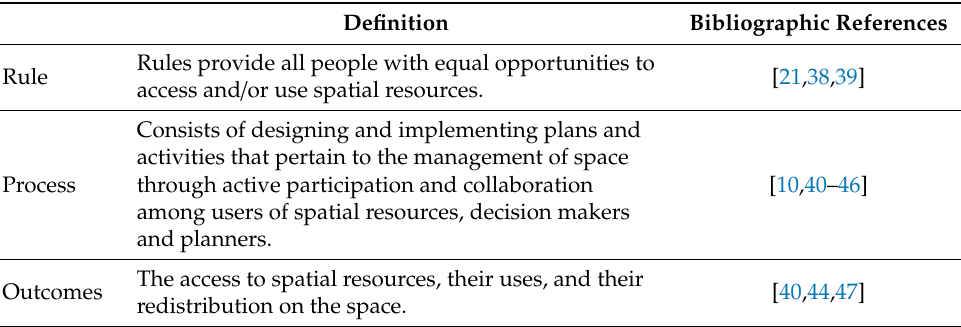
Table 1. Defining the three dimensions of spatial